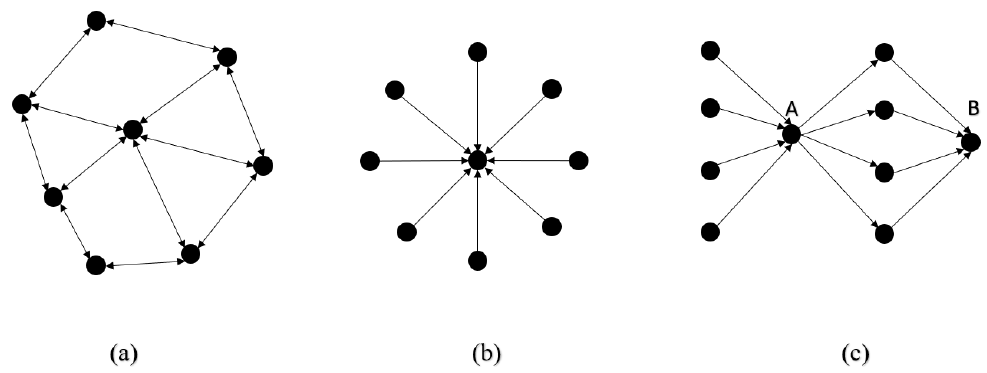
Figure 4. This figure illustrates the three network topologies employed in the simulations: ( a ) mesh, ( b ) star, and ( c )